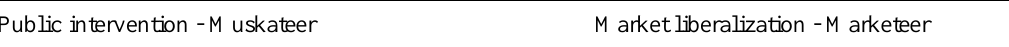
Table 3. Scenario principles for alternative plausible changes affecting European rural